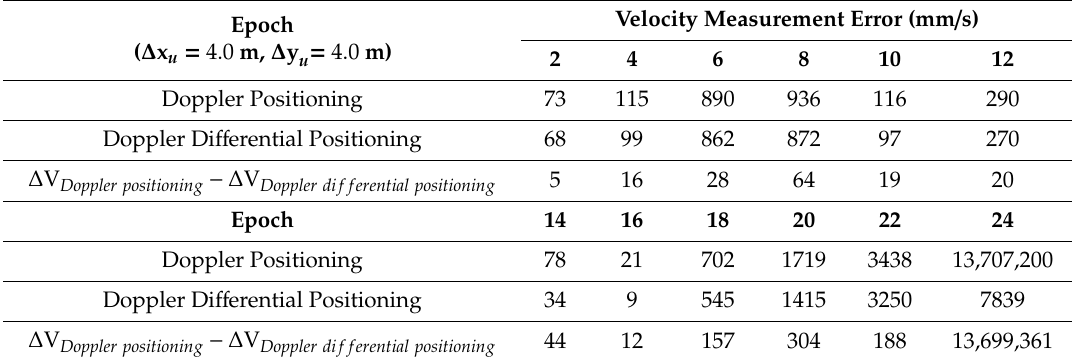
Table 5. Velocity measurement error caused by deviations of the receiver